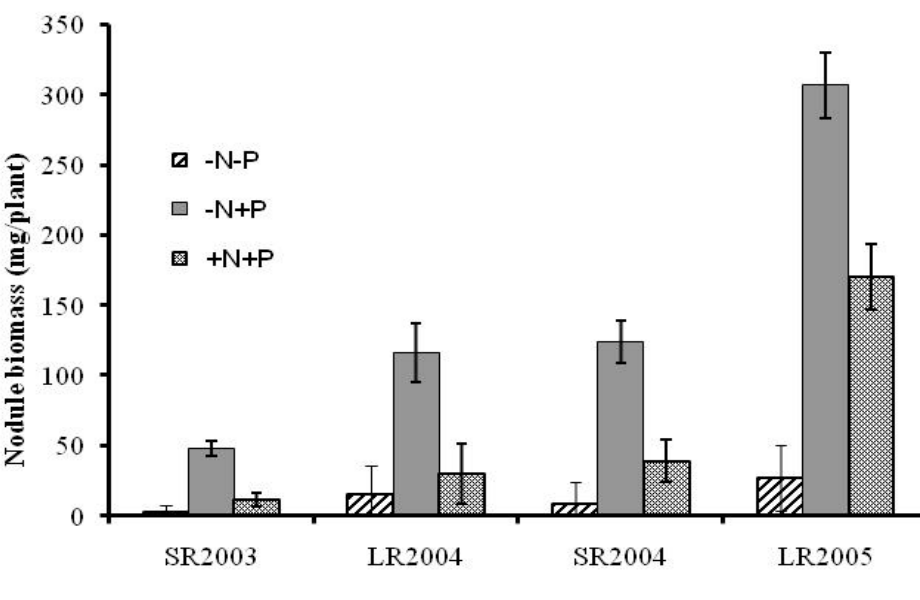
Figure 1. Effect of fertilizer N and P on soybean nodule weight in different seasons in Nyabeda, western Kenya, within soybean-maize rotation system. LR = long rainy season (usually March to August); SR = short rainy season (usually September to January), nitrogen and phosphorus were each applied at 60 kg N ha − 1 in plots indicated +N and +P, error bars are least significant